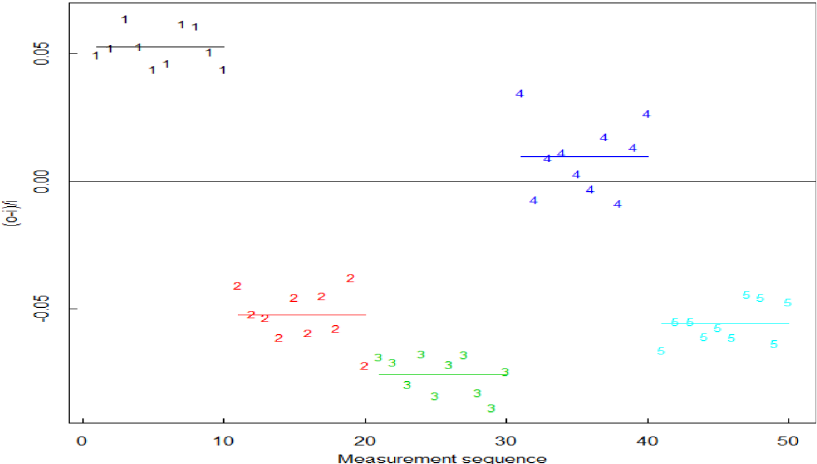
Fig. 1. Example simulated veri fi cation measurement data. The relative difference d ~ = ( o (cid:2) i )/ o is plotted for each of 10 paired ( o , i ) measurements in each of 5 groups, for a total of 50 relative differences. The mean relative difference within each group (inspection period) is indicated by a horizontal line through the respective group means of the paired